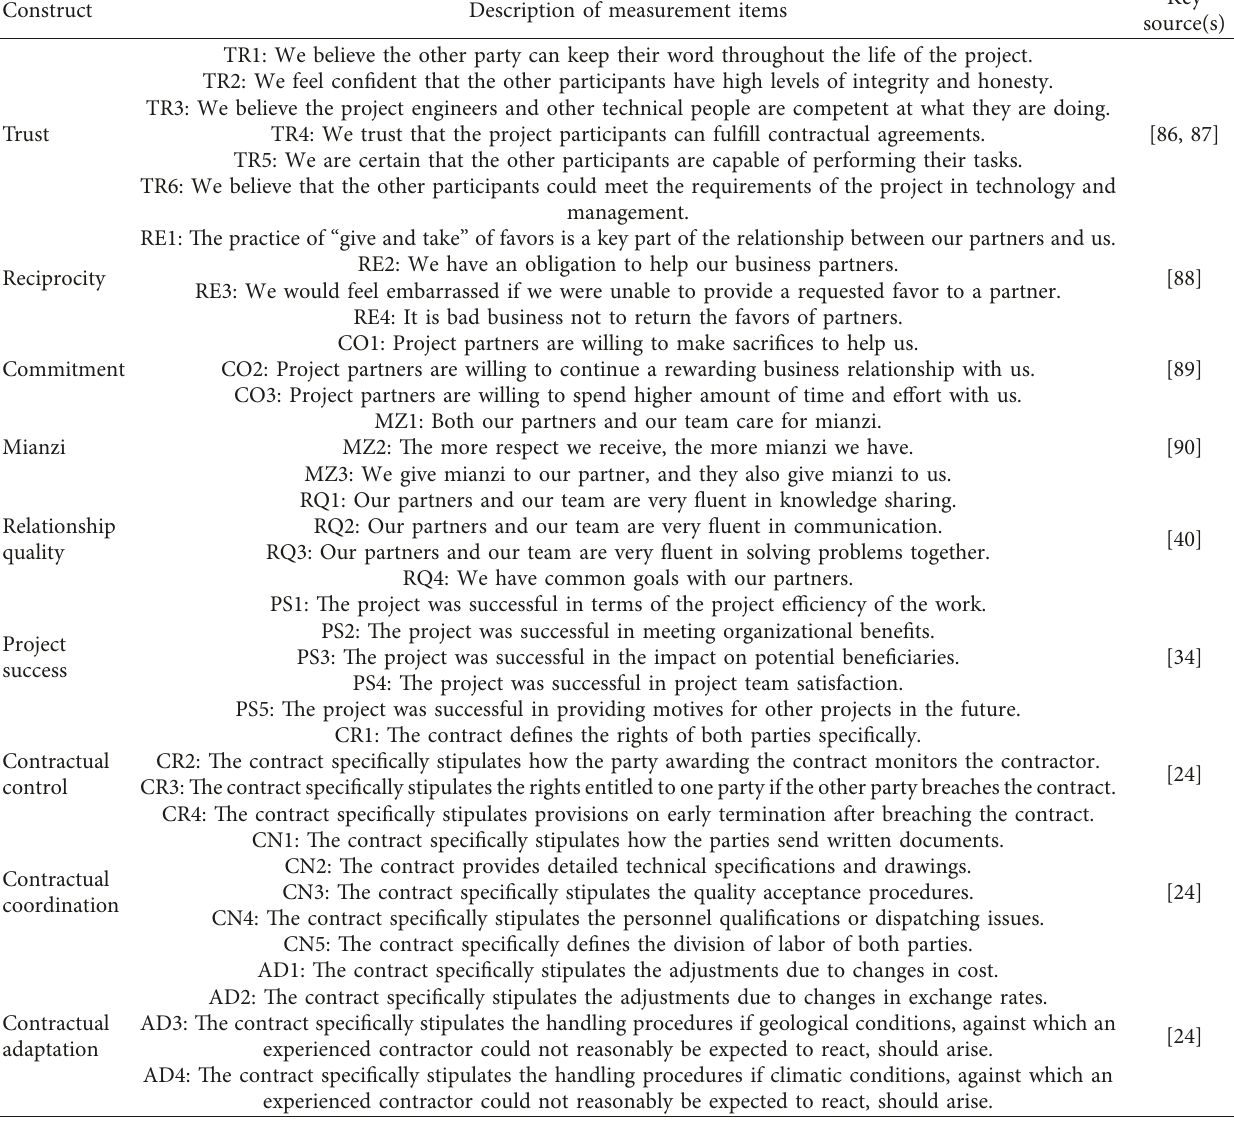
Table 2: Measures of constructs.